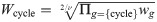
Evolutionary trajectory of a population adapting to a fast fluctuating environment displays selection for high nonlinearity.The initial population started from a non-optimal genotype (θ0) where k = 80, nH = 1, KD = 10 with evolutionary parameters N = 10000, ν = 0.1, st = 40, u = 0.03, and M = 1.1 both under (A) the original model and (B) in the absence of biochemical noise (CONTROL). The average KD (〈KD〉cycle) versus the average Hill coefficient (〈nH〉cycle) are shown for each environmental cycle simulated, colored given the geometric mean of the population fitness per environmental cycle (Wcycle=Πg={cycle}wg2/ν), and the marker size corresponds to the average percentage of bistable genotypes in the population (see legend). The traces of other nine replicas are shown in gray as a reference. Each cycle spans a LOW (dark green) and HIGH (light green) epoch and there are 500 environmental cycles over 10,000 generations for each of these simulations. The population fitness w per generation for the first and last cycles, as well as the cycle with the minimum and maximum Wcycle are shown in the bottom for comparison, and colored according to their Wcycle value. In both simulations (A-B), the population evolved to higher nonlinearity values 〈nH〉cycle and Wcycle.